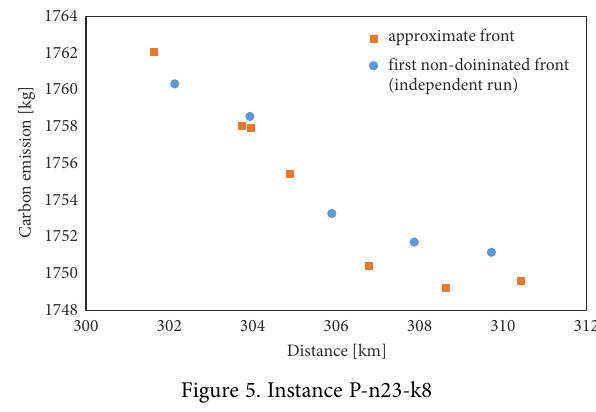
Figure 5. Instance P-n23-k8